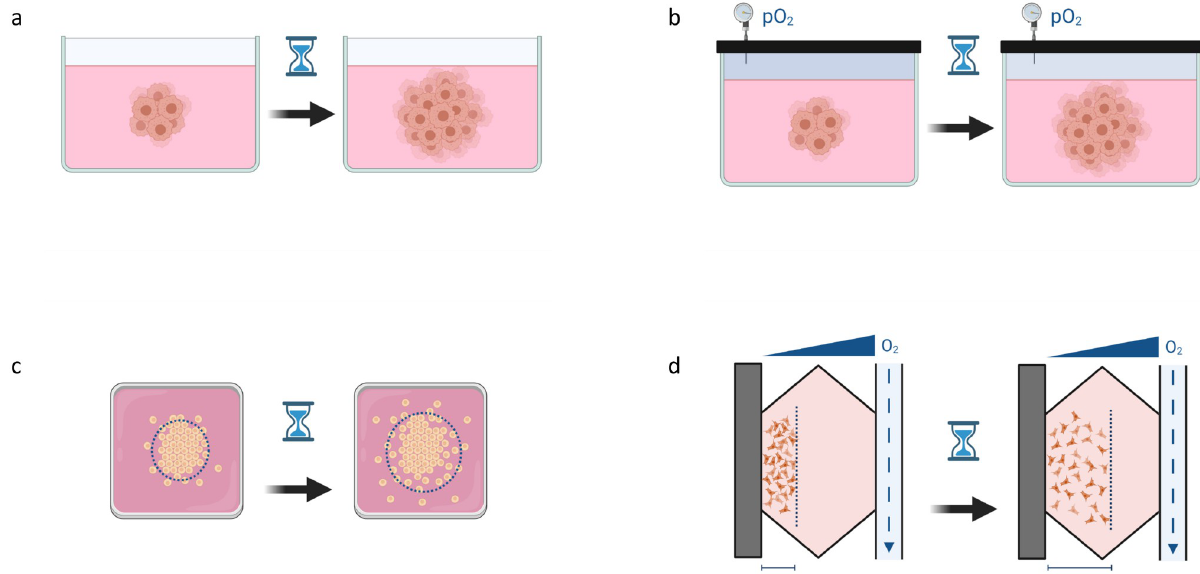
Fig 2. Scheme of the different experiments that can be performed to obtain the model parameters. Obtaining the source term parameters does not require a spatial cell distribution, although this is necessary for characterising the cell parameters associated with migration. ( a ) Determining α 1 and c s . ( b ) Determining α 2 and k m . ( c ) Determining D 1 . ( d ) Determining χ . Created with BioRender.com.